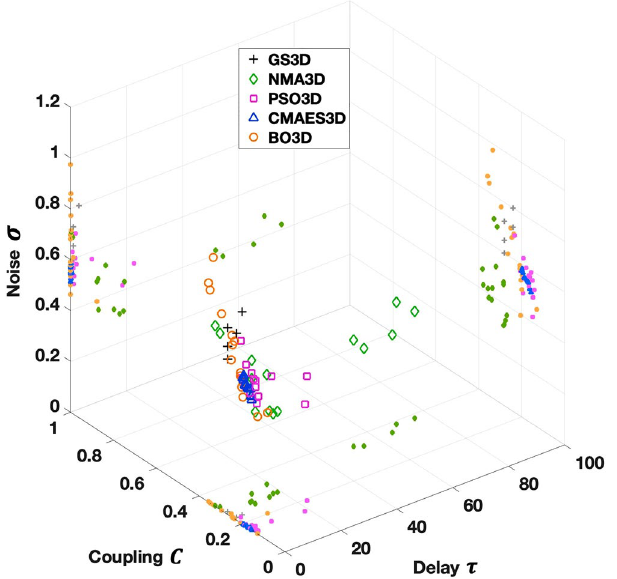
Figure 2. Exemplary parameter optimization in the 3Dim case. The outcomes (optimal parameter points) for all tested methods are combined in one plot. Besides the solutions in the 3Dim parameter space (larger markers), projections to 2Dim plains are presented (smaller markers). For the grid search in 3Dim (GS3D), five parameter points are considered (black crosses). In terms of the model similarity to empirical data, these points represent the five best solutions out of all values calculated on the parameter grid. As indicated in the legend, the results of the 3Dim parameter optimizations via NMA (NMA3D), PSO (PSO3D), CMAES (CMAES3D) and BO (BO3D) are visualized by colored diamonds, squares, triangles and circles, respectively. For each algorithm, 15 markers are shown (plus projections) which indicate the solutions of 15 runs executed at random initial conditions. The figure was created with MATLAB R2018a (www. mathw orks. com).